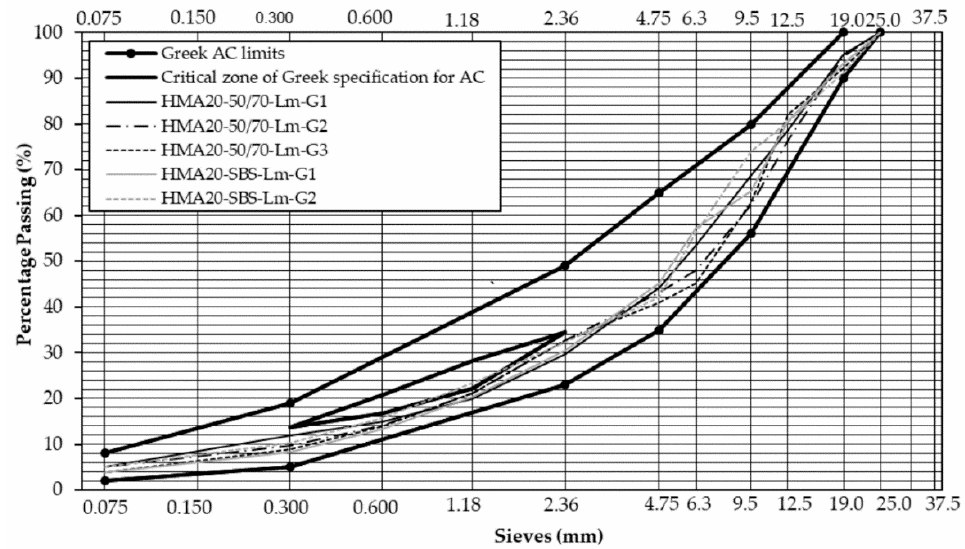
Figure 4. Grading curves of HMA20-50/70-Lm and HMA20-SBS-Lm.